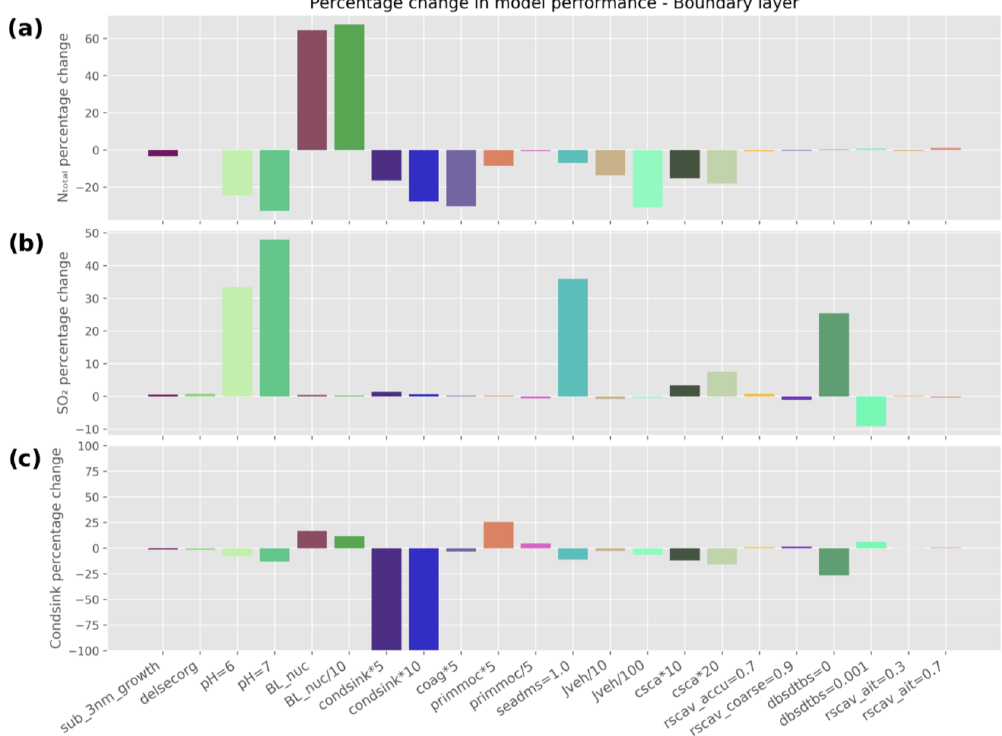
Figure 6. Percentage change in model performance for different perturbation simulations in the boundary layer (altitude < 1km) with respect to (a) N Total , (b) SO 2 , and (c) condensation